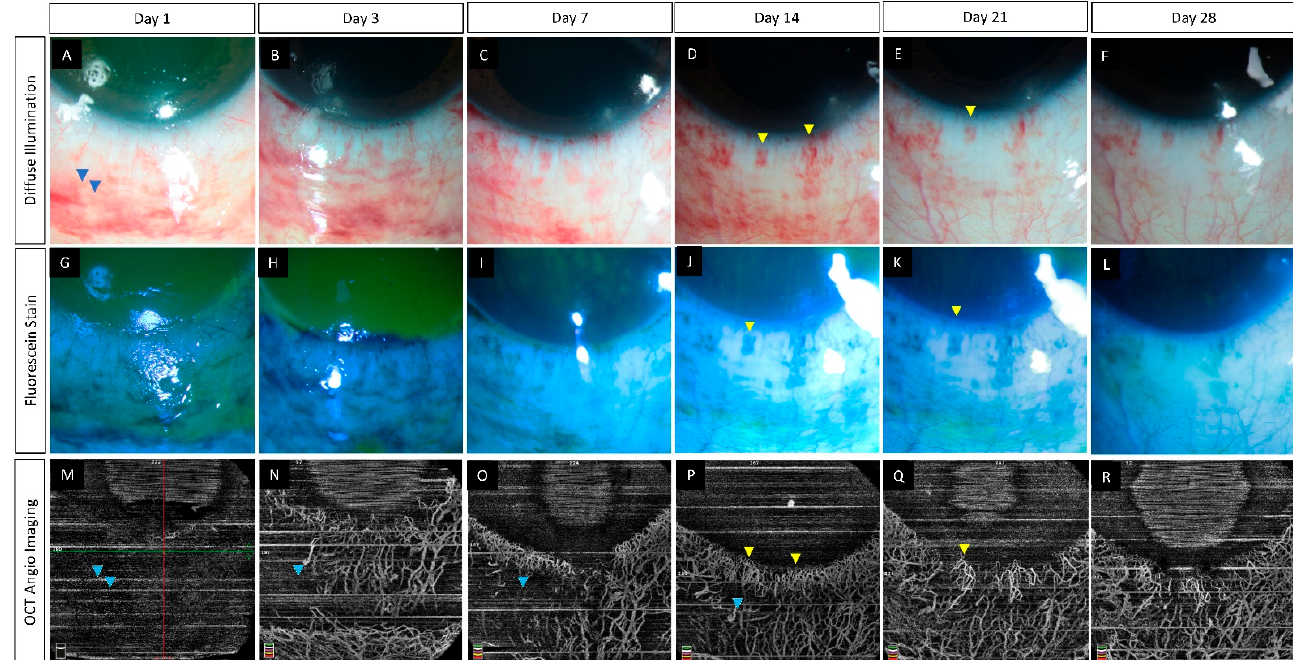
Figure 1. ( A – R ) Serial monitoring with slit lamp photographs (without and with fluorescein staining) along with anterior segment optical coherence tomography angiography (AS-OCTA) imaging in an eye with acute chemical burns. ( A – L ) These images show the progressive healing of the corneal and conjunctival epithelial defects in the inferior part of the eye which is complete by day 7. ( M – R ) AS-OCTA images show a blocked signal in the initial three visits due to the subconjunctival hemorrhages inferiorly (blue arrow heads) with clear delineation of the vasculature following the resolution of the hemorrhages. The hemorrhages abutting the limbus, however, have not affected the vascular signal (yellow arrow